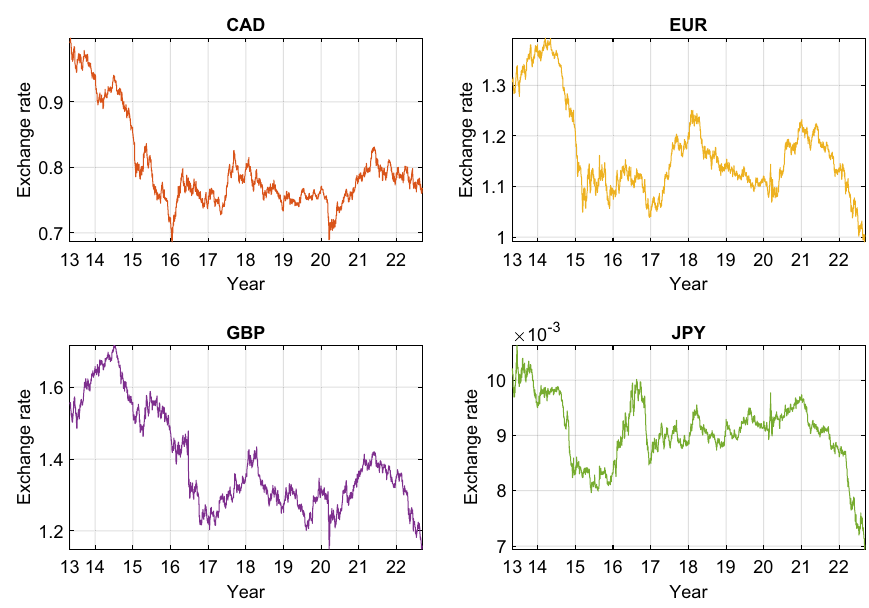
Fig. 2 The G7 exchange rates quoted against the